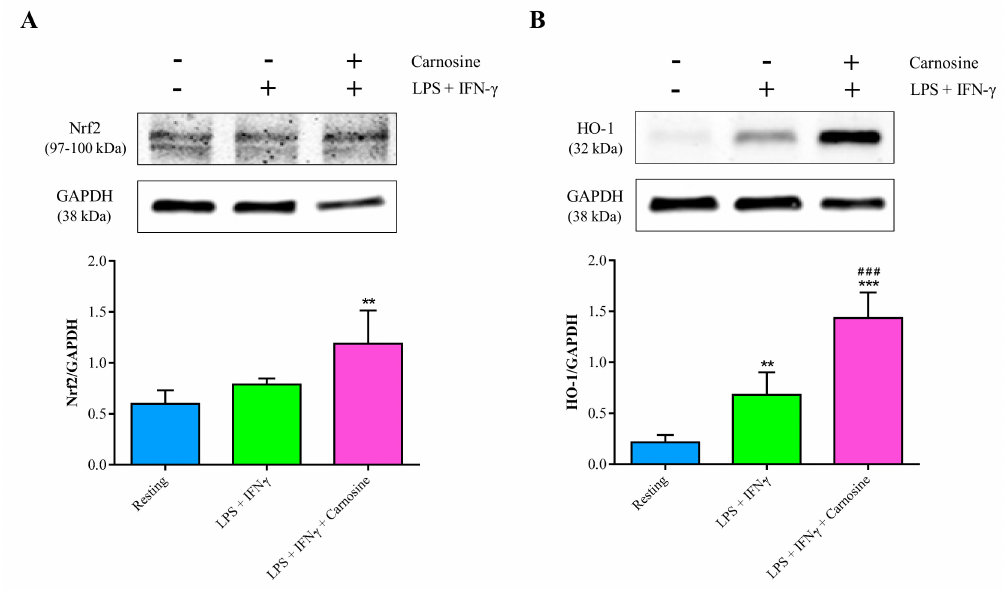
Figure 8. Representative immunoblots of ( A ) Nrf2 and ( B ) HO-1 in total protein extracts from resting (control) RAW 264.7 macrophages and in macrophages stimulated with LPS (100 ng / mL) + IFN- γ (600 U / mL), in the absence or in the presence of carnosine (20 mM). The abundance of each protein of interest was expressed relative to the abundance of the GAPDH protein, as an internal control. Histograms refer to the means ± SD of three to four independent experiments. ** p < 0.01 vs. resting; *** p < 0.001 vs. resting; ### p < 0.001 vs. LPS + IFN- γ